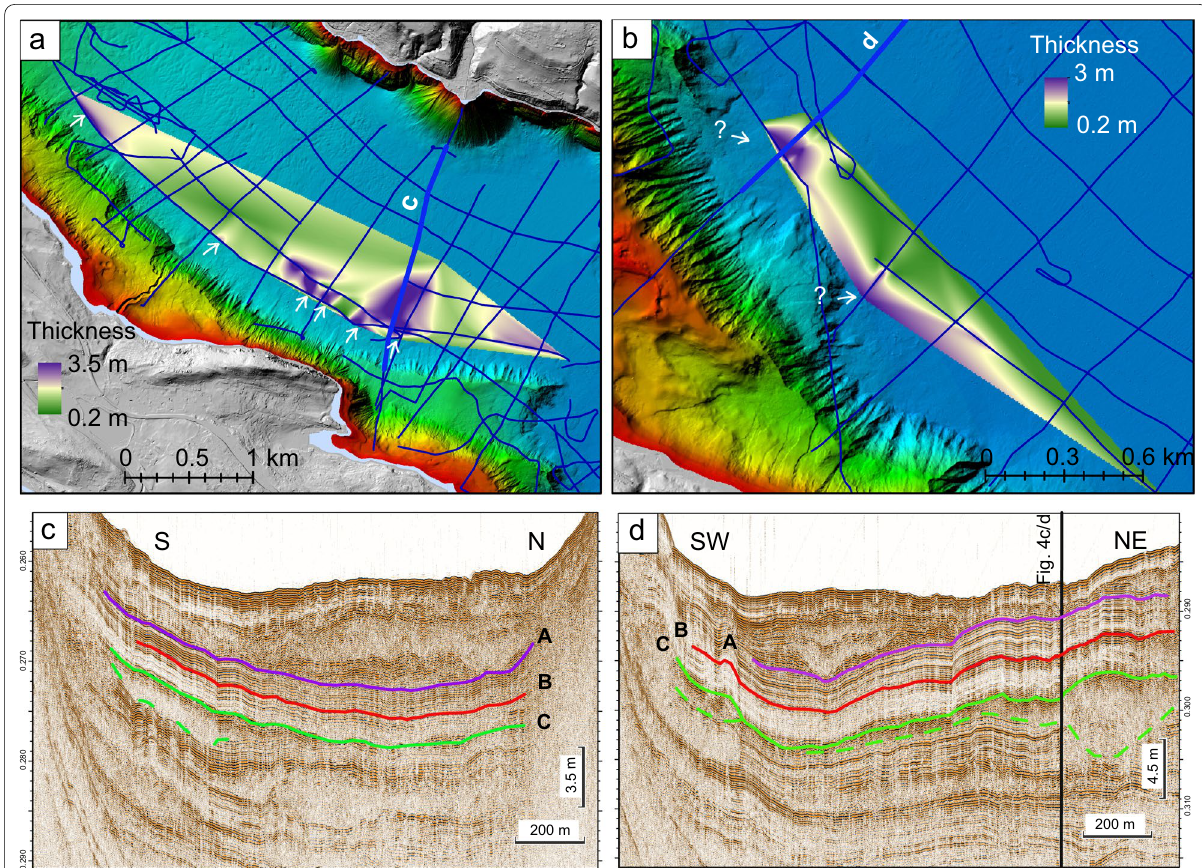
Fig. 5 Thickness distribution maps of the smaller mass-movement deposits topped by Horizon C at the southern shore ( a and b ) and two pinger profiles showing the MMDs within the lacustrine sediment column ( c and d ). The outline of the map and the position of the pinger profiles are shown in Fig. 1a. The thicker blue lines in a and b mark the position of the pinger profiles in c and